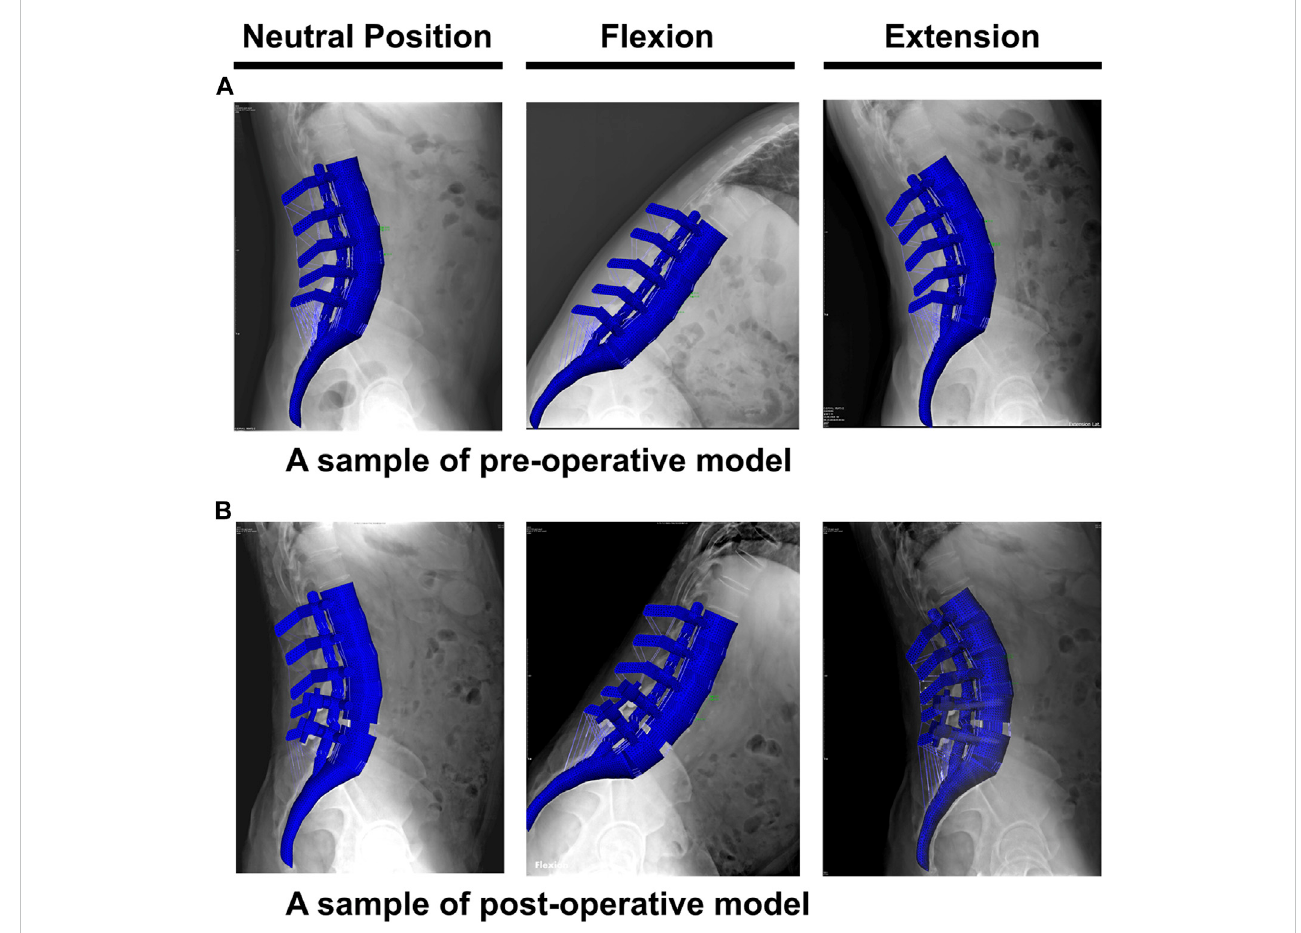
FIGURE 3 A schematic sample of comparison between the fi nite element results and the functional X-ray images in the neutral position, fl exion, and extension for (A) pre-operative and (B) post-operative